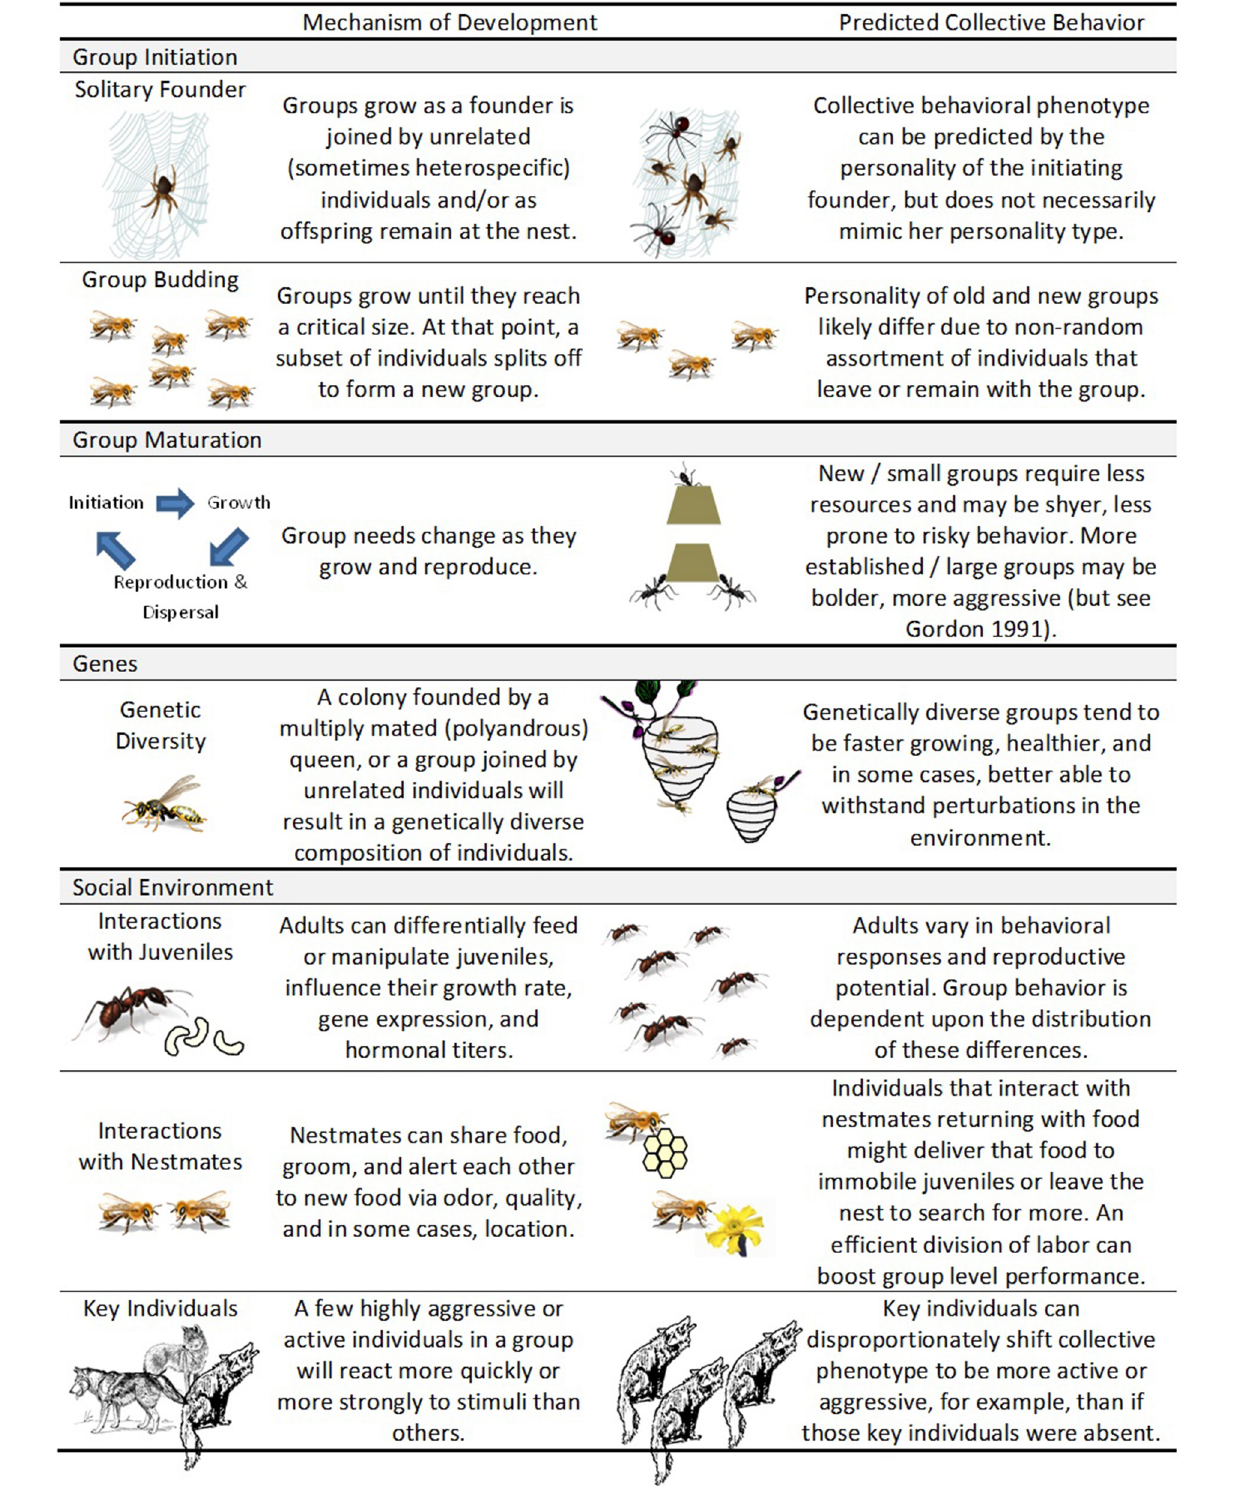
Frontiers in Ecology and Evolution | Behavioral and Evolutionary